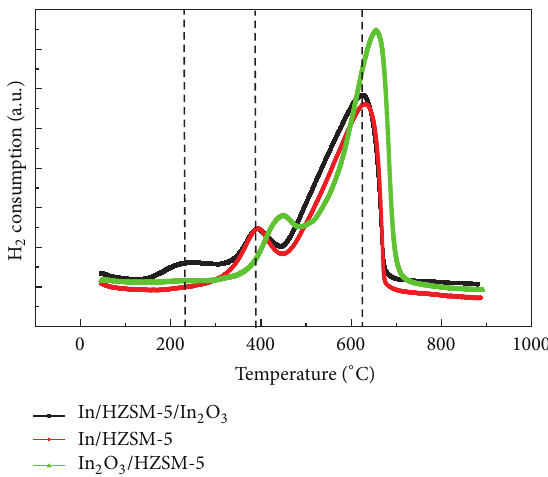
Figure 11: H 2 -TPR profiles over In/HZSM-5, In/HZSM-5/In 2 O 3, and In 2 O 3 /HZSM-5 catalysts. (In content equals 20% for all three